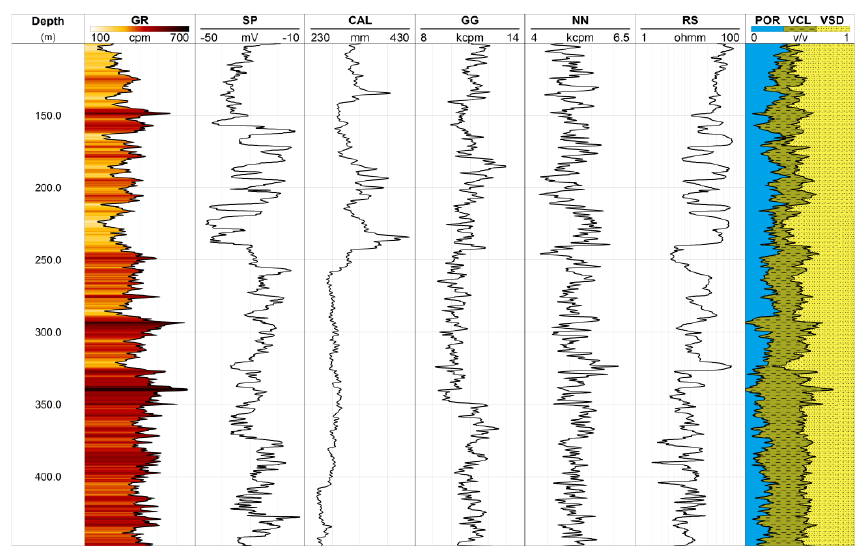
Figure 10. Observed wireline logs (tracks 1-6) and the estimated petrophysical parameters of porous groundwater formations (track 7) in Baktalórántháza-1 well, northeast Hungary. Grain-sizes were derived by laboratory measurements made on 220 core samples.